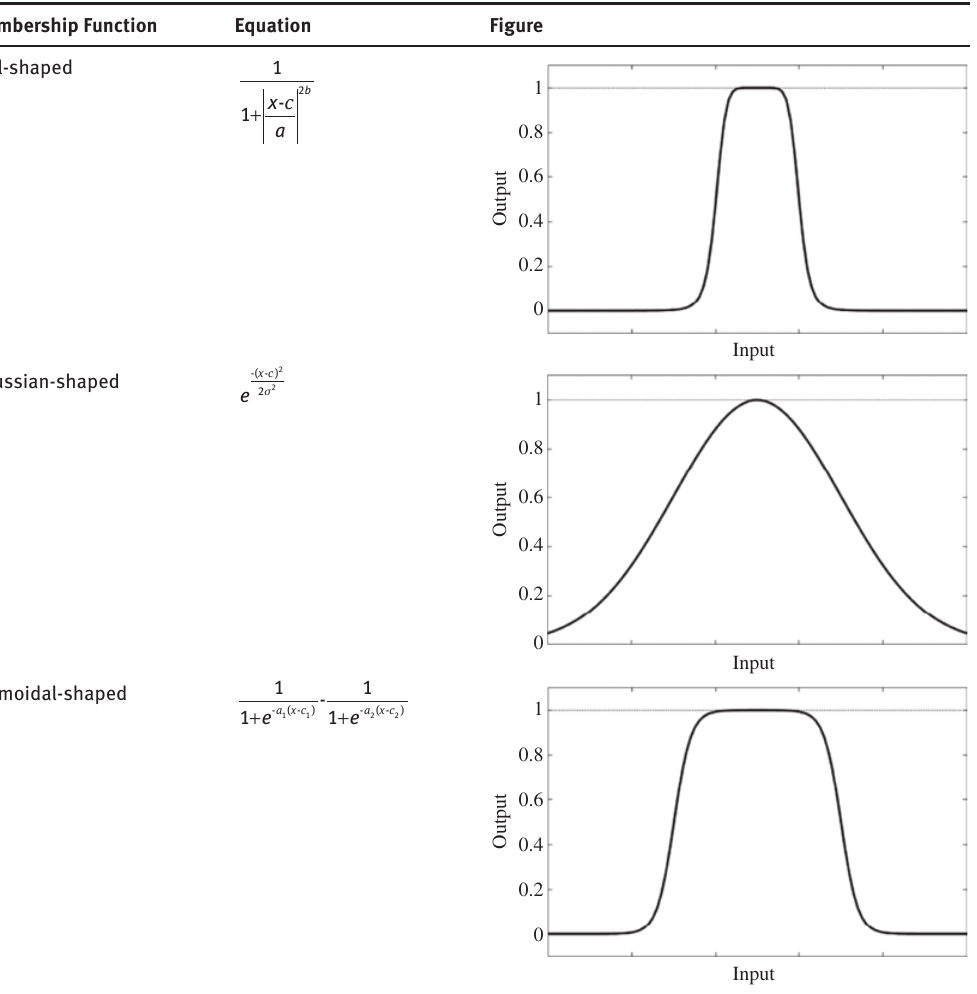
Table 2 Specifications of MFs employed in ANFIS